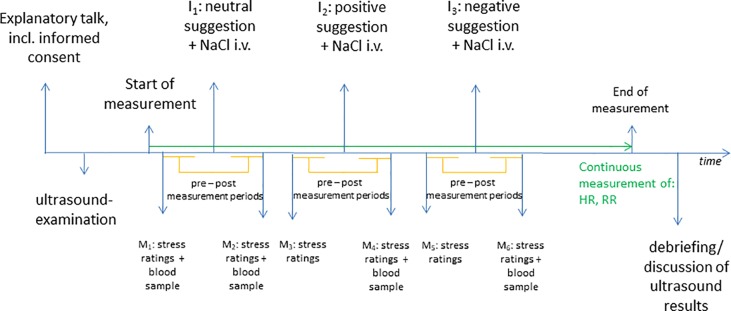
Procedure. M, Measurement; I, Intervention; HR, heart rate; RR, blood pressure.